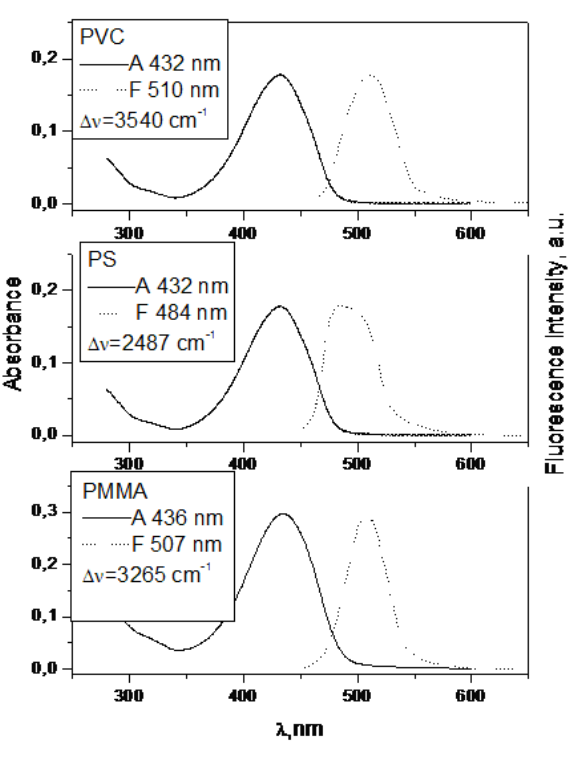
Figure 9. Absorption and fluorescence spectra of 2 in PMMA, PS and PVC at 0,002 mol kg − 1